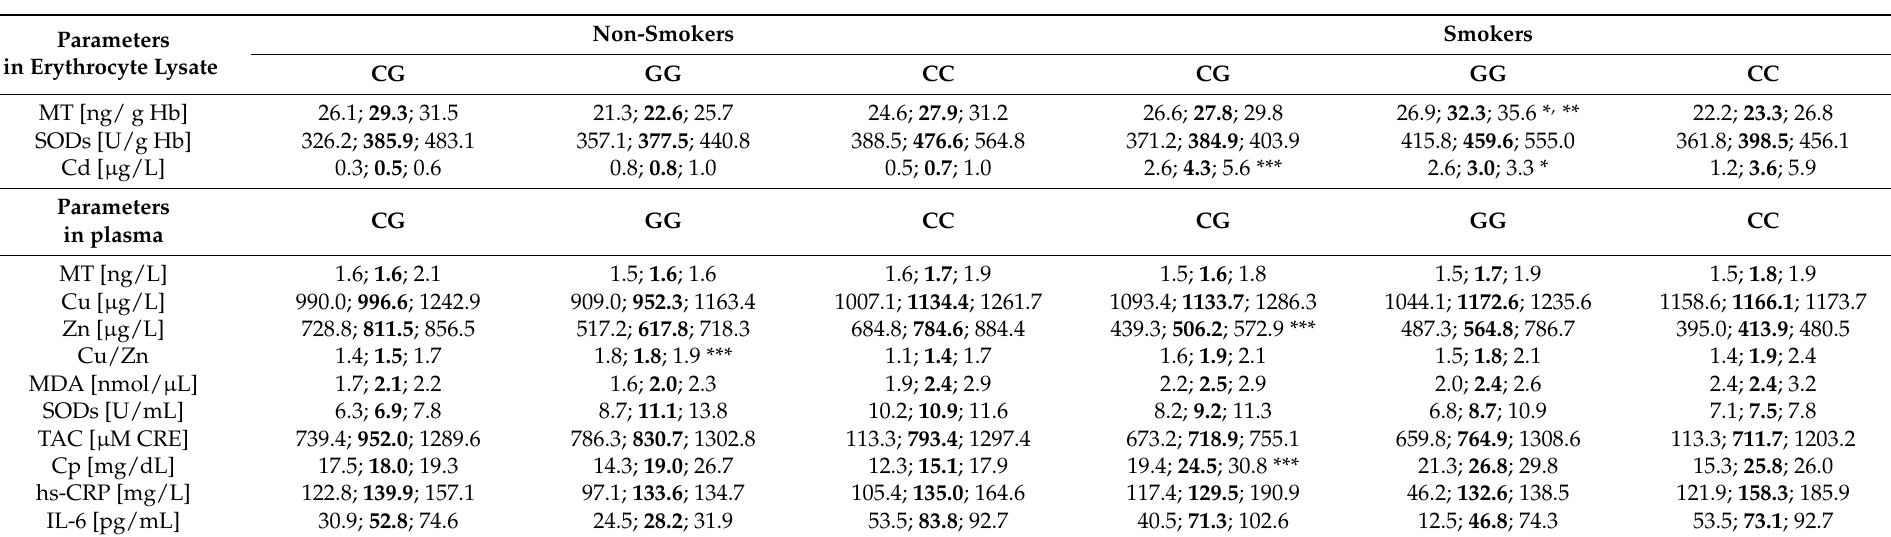
Table 6. The concentration of metals (Cu, Zn and Cd), MT, Cp and markers of inflammation and oxidative stress in groups of non-smoking and smoking patients with AP, with regard to genotypes for rs964372 in the MT1B gene. The bold is to distinguish the median values.